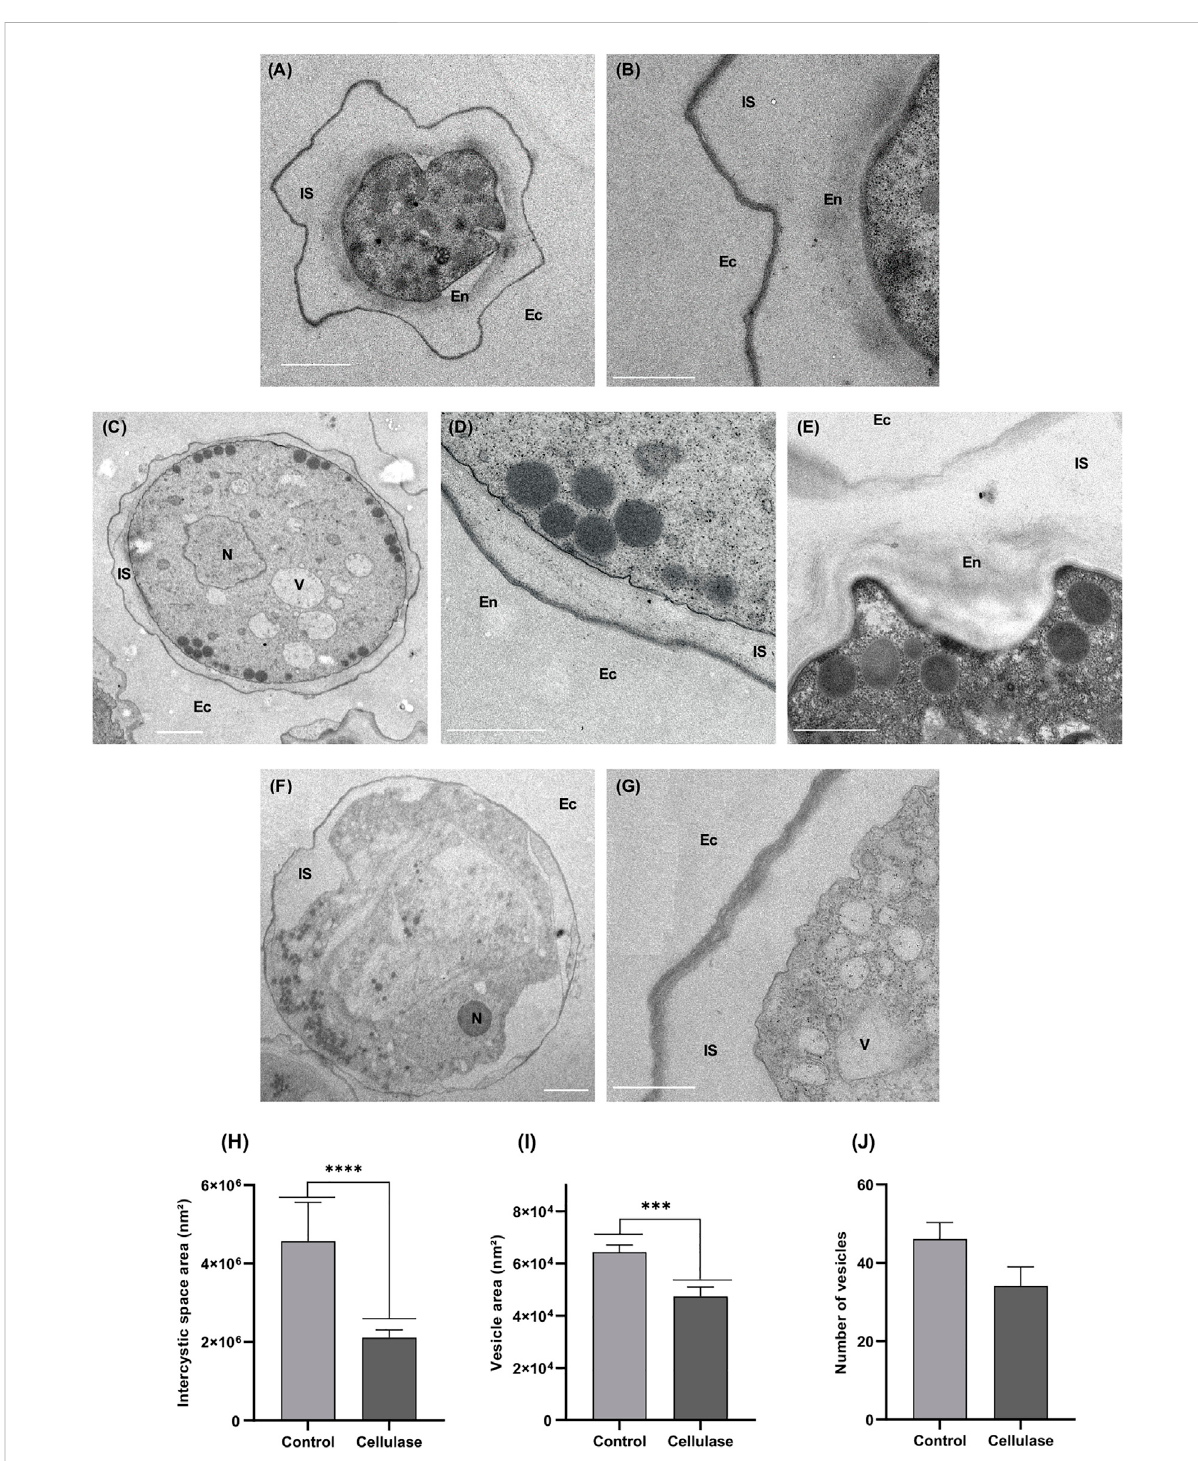
FIGURE 8 Analysis intransmissionelectron microscopy of A.castellanii cyststreatedat30 ° Cfor 48 hintheabsence (A,B) orinthepresence (C – G) of5 U/ mL cellulase. Treated cysts are characterized by a reduction of the intercystic space (C,D,F,G) in comparison to the control (A,B) , with an endocyst eitherscarcelyvisualizable (C,D) orabsent (F,G) .Sometreatedcystsdisplayedadistancebetweenendocystandectocystcomparable tothecontrol, butwithadisturbedendocystandthepresenceof fi brillar materialreleasedwithintheintercysticspace (E) .Intreatedcysts,lipidicvesicleswere mostly localizedattheperipheryoftheamoeba (C,F) , inoppositiontothecontrol (A) .En,Endocyst;Ec,ectocyst;IS,Intercystic Space,N,Nucleus,V, Vacuole; White arrow: lipidic vesicle; Double black arrow: fi brillar material within the intercystic space. Scale bars represent 2 µm (A,F) , and 1 µm (B,C,D,E,G) . The intercystic space area (H) as well as the lipidic vesicle area (I) and number (J) were determined in cellulase-treated and untreated amoebae. The results correspond to the mean of 30 cells ±SEM. Three independent experiments were